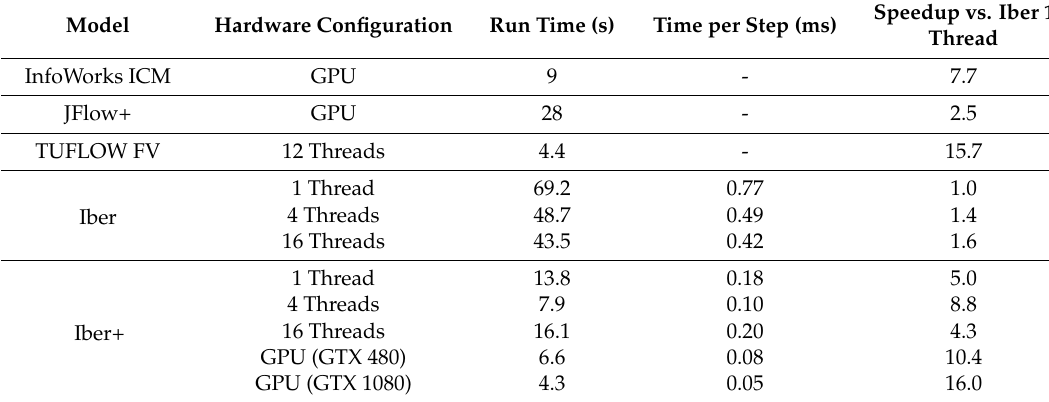
Table 2. Performance measurements obtained for Test 1. Total run time of the simulation in seconds, average processing time per time step in milliseconds and the achieved speedups compared with Iber running in a single